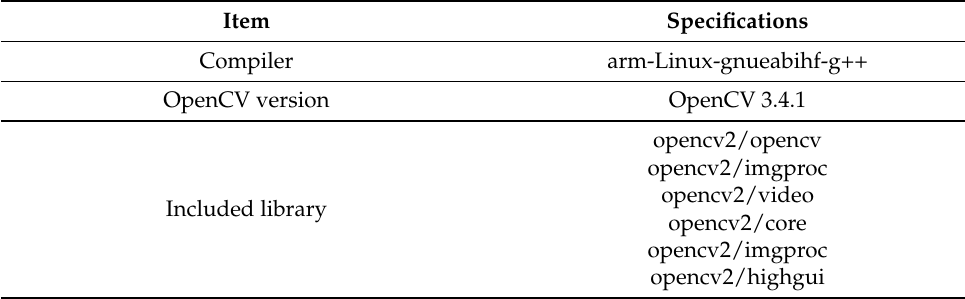
Table 1. Cross-compilation environment for system